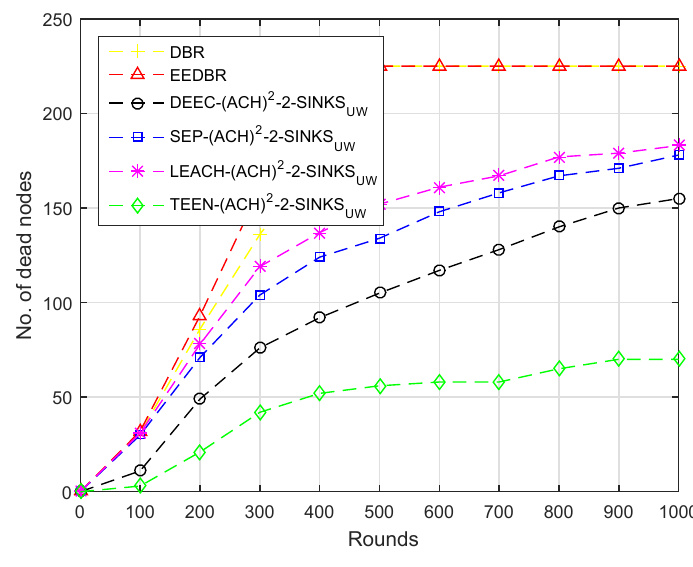
Figure 14. Number of Dead Nodes.